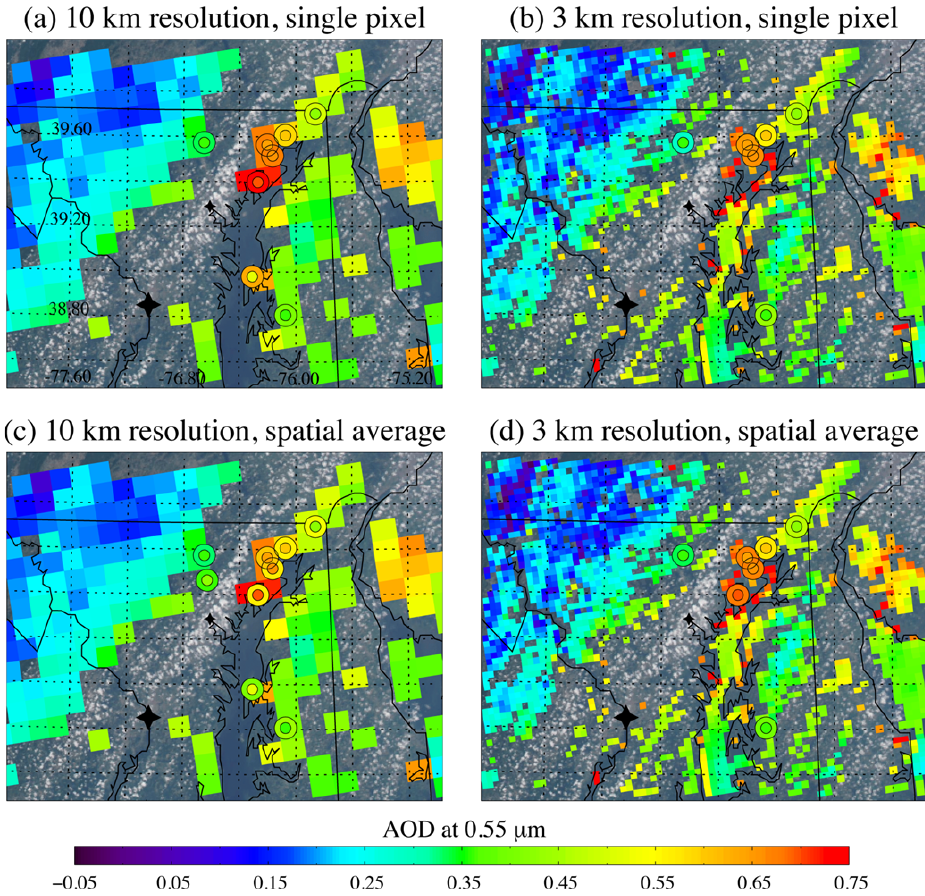
Fig. 1. AOD at 0.55µm observed by MODIS-Aqua on 21 July 2011 at 18:30UTC is plotted at the 10km resolution ( a and c ) and 3km resolution ( b and d ). MODIS/SP collocations are plotted in the circles. In (a–d) , the inner circle is the SP temporally averaged AOD, which is an average of ≥ 2SP measurements within 30min of MODIS overpass. In (a) and (b) , the outside circle is the AOD of the MODIS pixel containing the SP site. In (c) and (d) , the outer circle is the spatial average of a MODIS AOD in a 5 × 5 pixel box around the SP station. Only land pixels with a QA=3 are used in the collocation. Washington D.C. is shown with the large black star and Baltimore, MD is shown with the small black star. The true color image, created from the MODIS red, green and blue bands, is shown in the background.